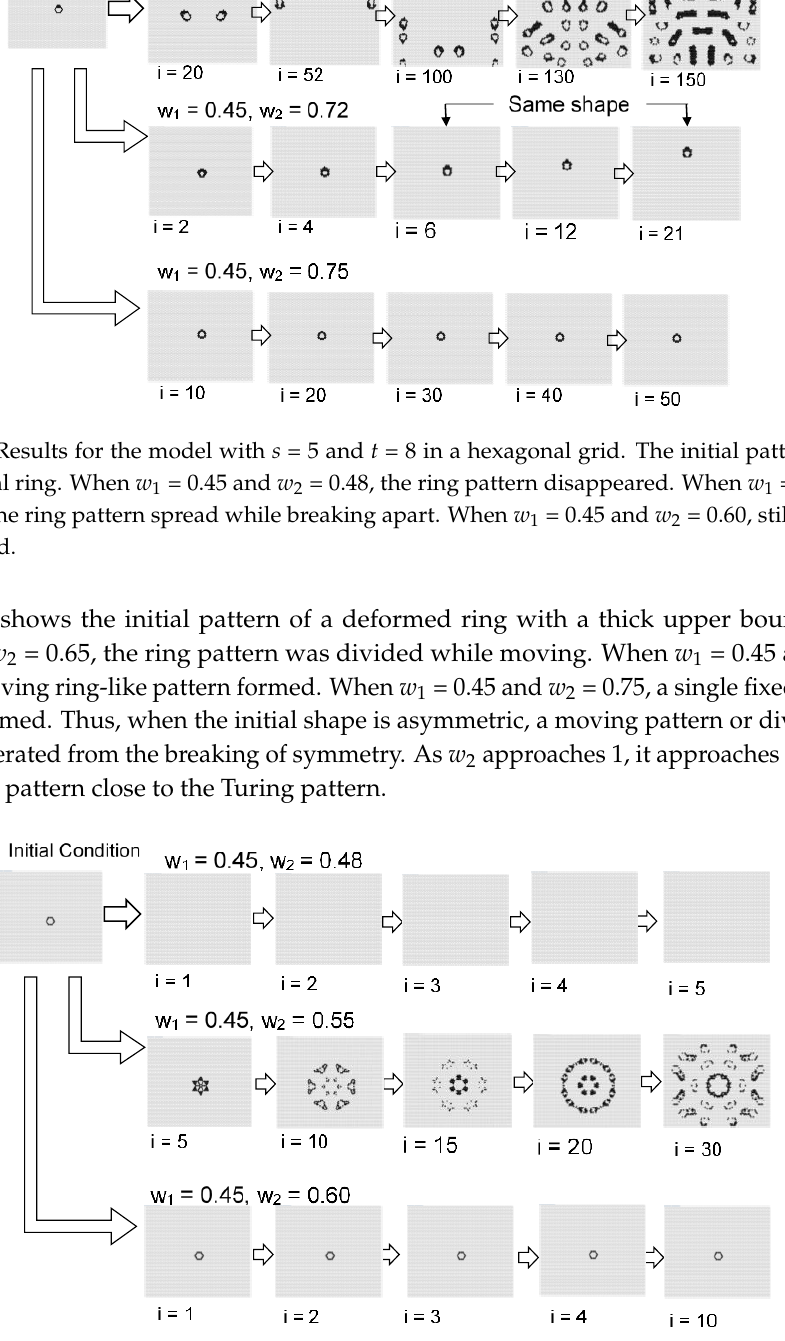
Figure 16. Results for the model with s = 5 and t = 8 in a hexagonal grid. The initial pattern was a symmetrical ring. When w 1 = 0.45 and w 2 = 0.65, the ring pattern became an oscillation pattern with period 2. When w 1 = 0.45 and w 2 = 0.72, the ring pattern likewise became an oscillation pattern with period 2. When w 1 = 0.45 and w 2 = 0.75, a still pattern was formed.